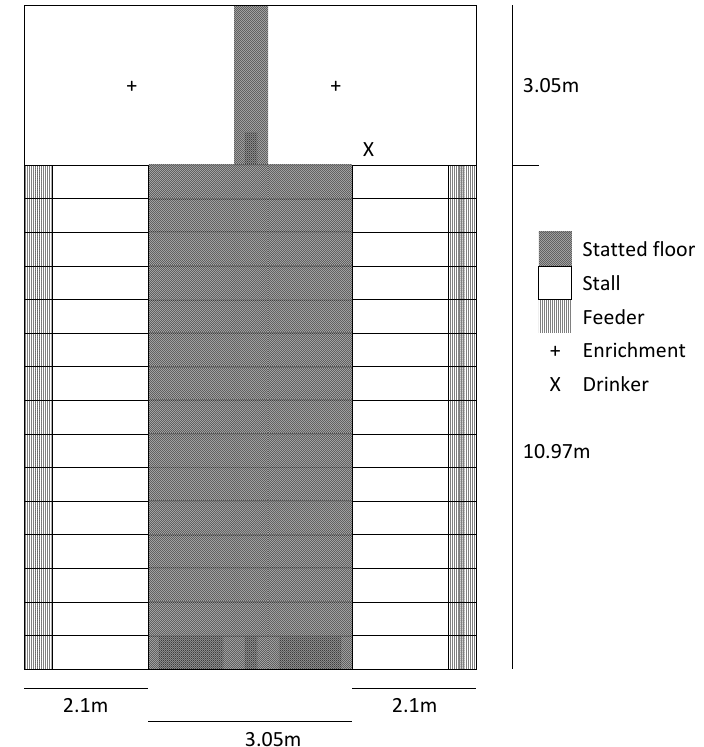
Figure 1. Schematic diagram of a gestation pen.